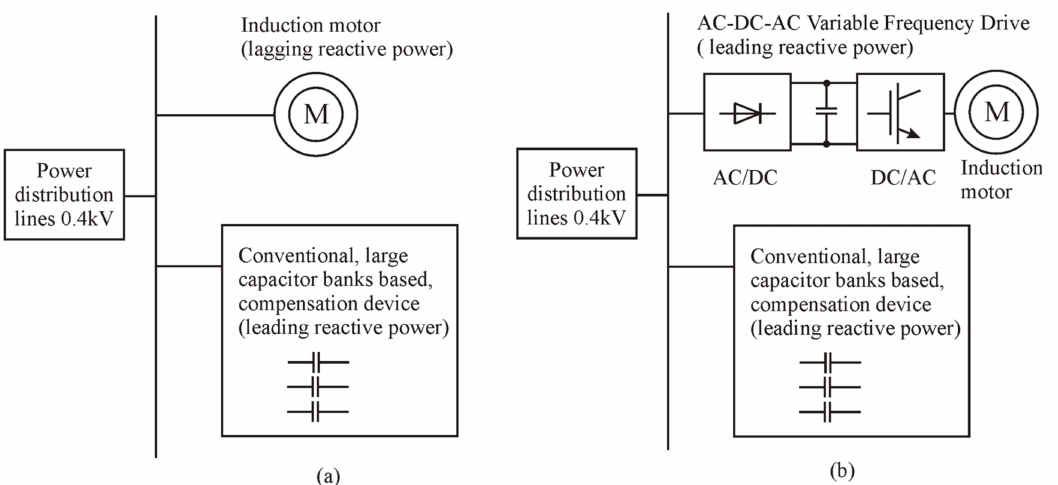
Figure 1. The loads and compensation devices of a 0.4 kV PDL: ( a ) conventional load equipment; ( b ) current load equipment (causes overcompensation).